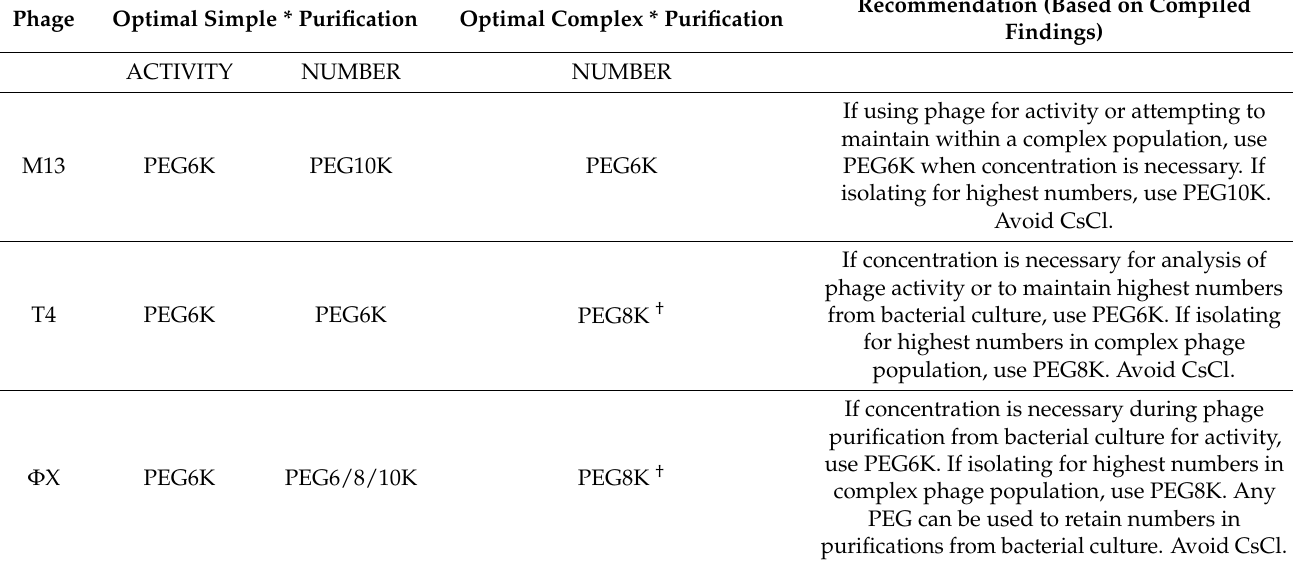
Table 1. Summary of phage purification